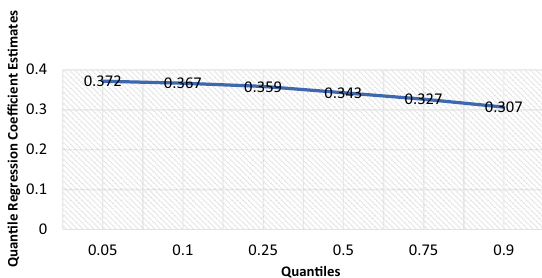
Fig. 12 Plot of coefficients of quantile regression for MIL_GDP and RGDPPCP